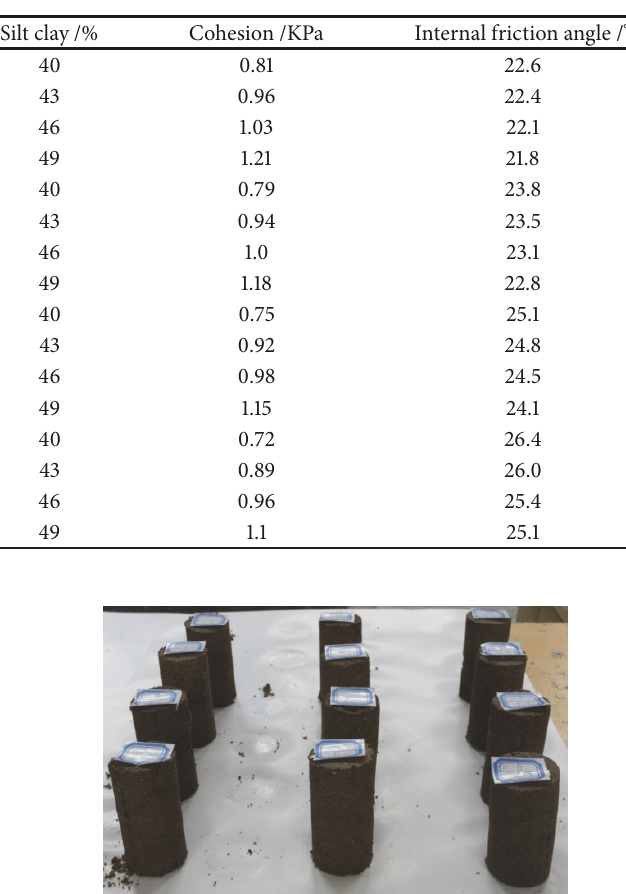
Table 2: Orthogonal test ratio parameter results of similar materials.